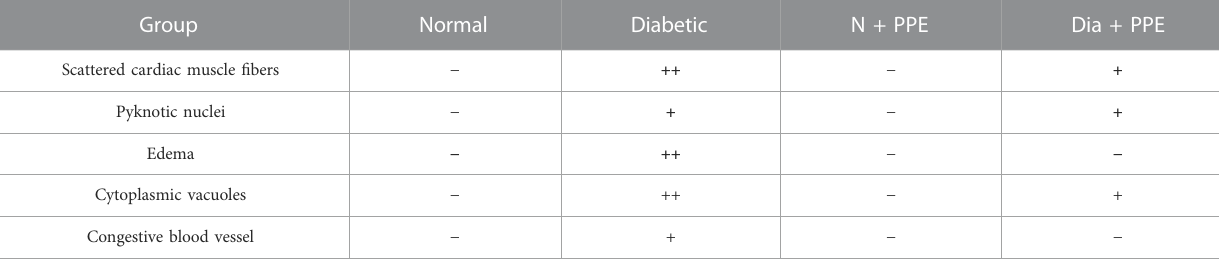
TABLE 2 Effect of pomegranate peel extract (PPE) on histopathological scoring of alterations caused by diabetes in rats ’ cardiac tissues of the studied groups. Group Normal Diabetic N + PPE Dia + PPE Scattered cardiac muscle fi bers −